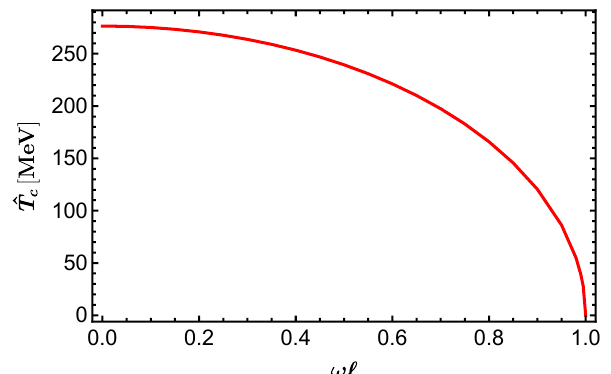
Figure 9 . The ˆ T − ω phase diagram of the pure gluon system. The critical temperature of the first-order phase transition decreases as ω is